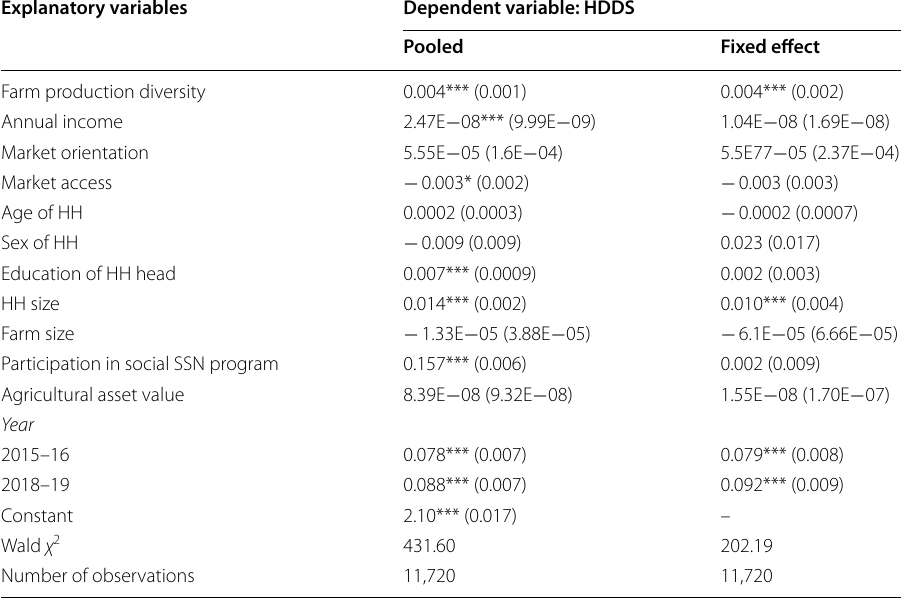
Authors’ analyses using 3 rounds of BIHS panel data ***, ** and * indicate significance at the 1% 5% and 10% levels, respectively; figures in the parentheses are standard errors